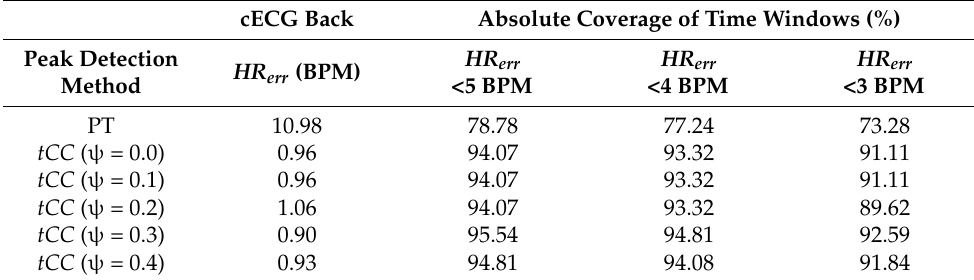
Table 2. cECG HR err and absolute coverage of various HR err criteria for 6 s windows measured on back for each peak detection method in the resting states after arm motion. cECG Back